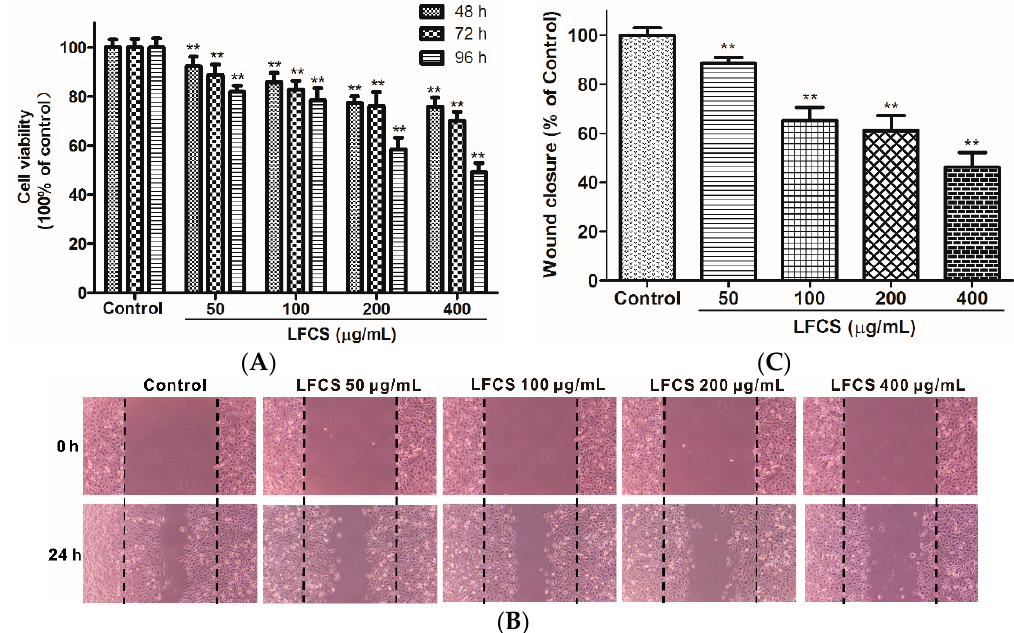
Figure 3. LFCS inhibited LLC cell proliferation and cell migration. ( A ) Inhibitory effect of LFCS on LLC cell proliferation. LLC cells were treated with 50, 100, 200, and 400 μ g/mL LFCS separately for 48 h, 72 h and 96 h and measured for viability by MTT assay. Values relative to that of control group (in which cell viability is set as 100%) were shown; ( B ) inhibitory effect of LFCS on LLC cell migration. Representative photos of wound closures after treatment with LFCS or not (40× magnification). Black dotted lines indicate the wound edge; and ( C ) quantification of the effect of LFCS on LLC cell migration in the wound healing assay. Wound closure relative to that of control group (in which wound closure is set as 100%) was determined. Data were derived from three independent experiments and presented as mean ± SD. ** p < 0.01, significant difference compared with control group.